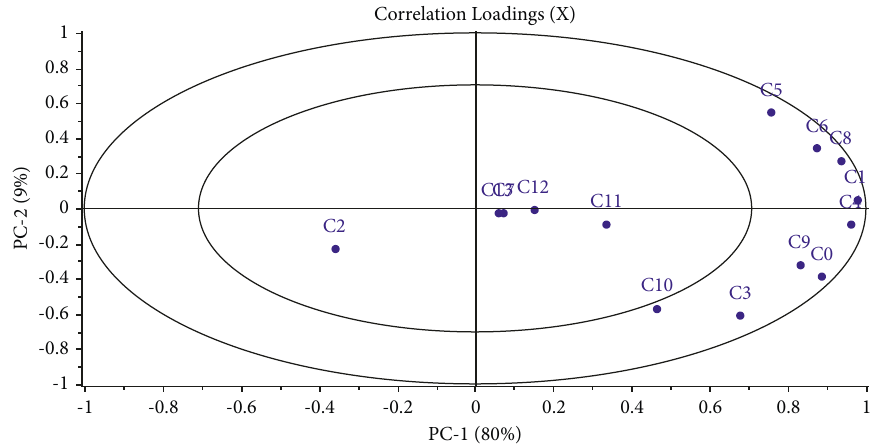
Figure 2: Loadings analysis of T . fuciformis from different Table 2: Composition of volatile components of T . fuciformis .